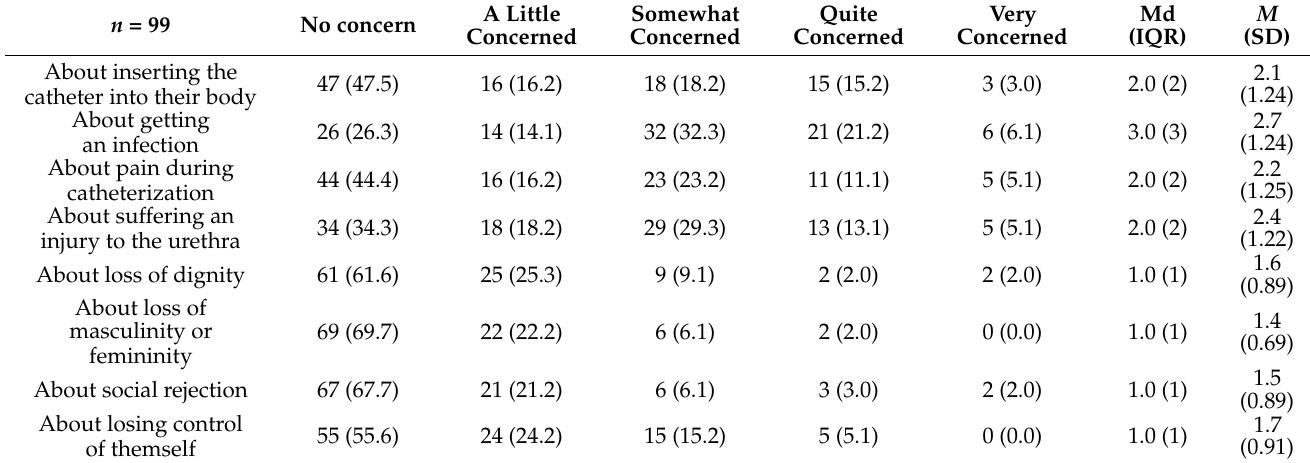
Table 4. Patients’ degree of concern over different problems that could be attributed to catheterization at the first visit. n = 99